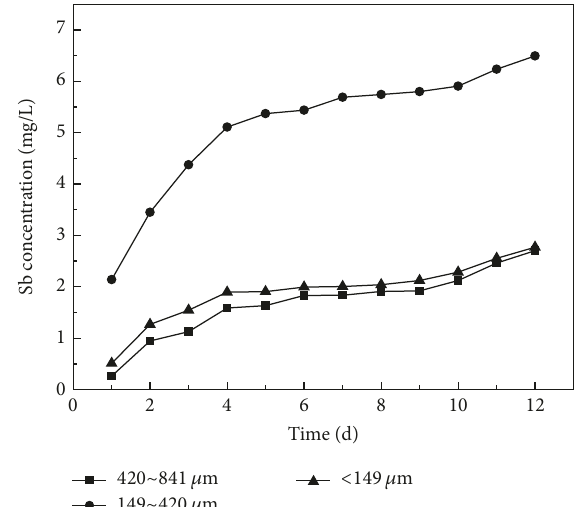
Figure 5: Effect of particle size on Sb release characteristic of smelting slag in static immersion test.